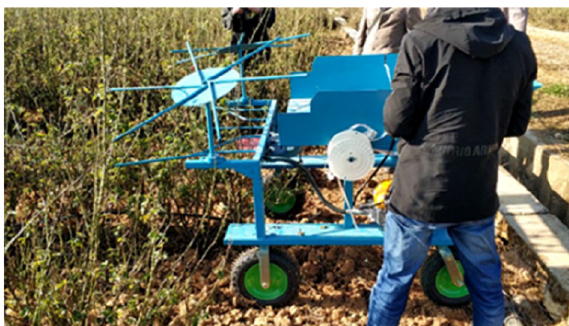
Figure 4. Field cutting